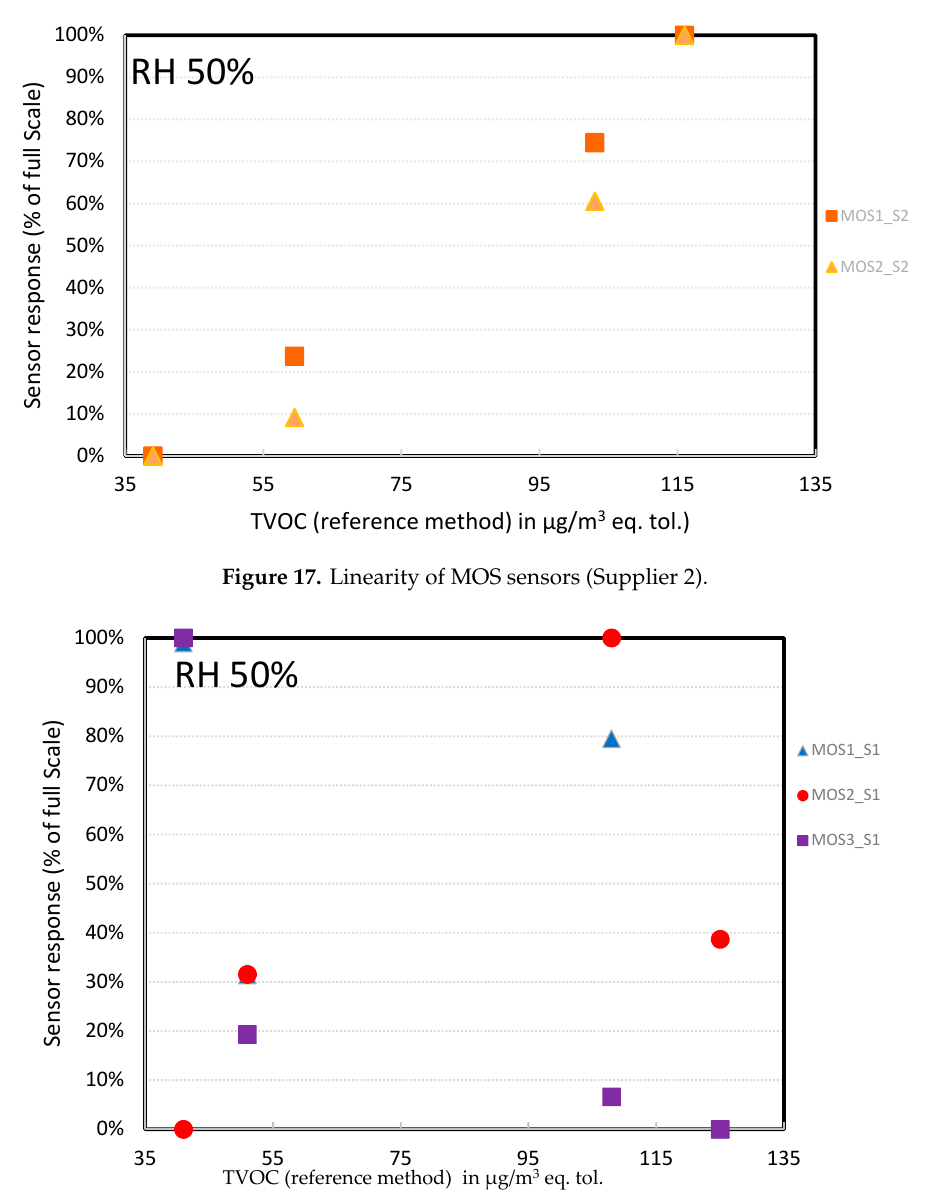
Figure 18. Linearity of MOS sensors (Supplier 1).